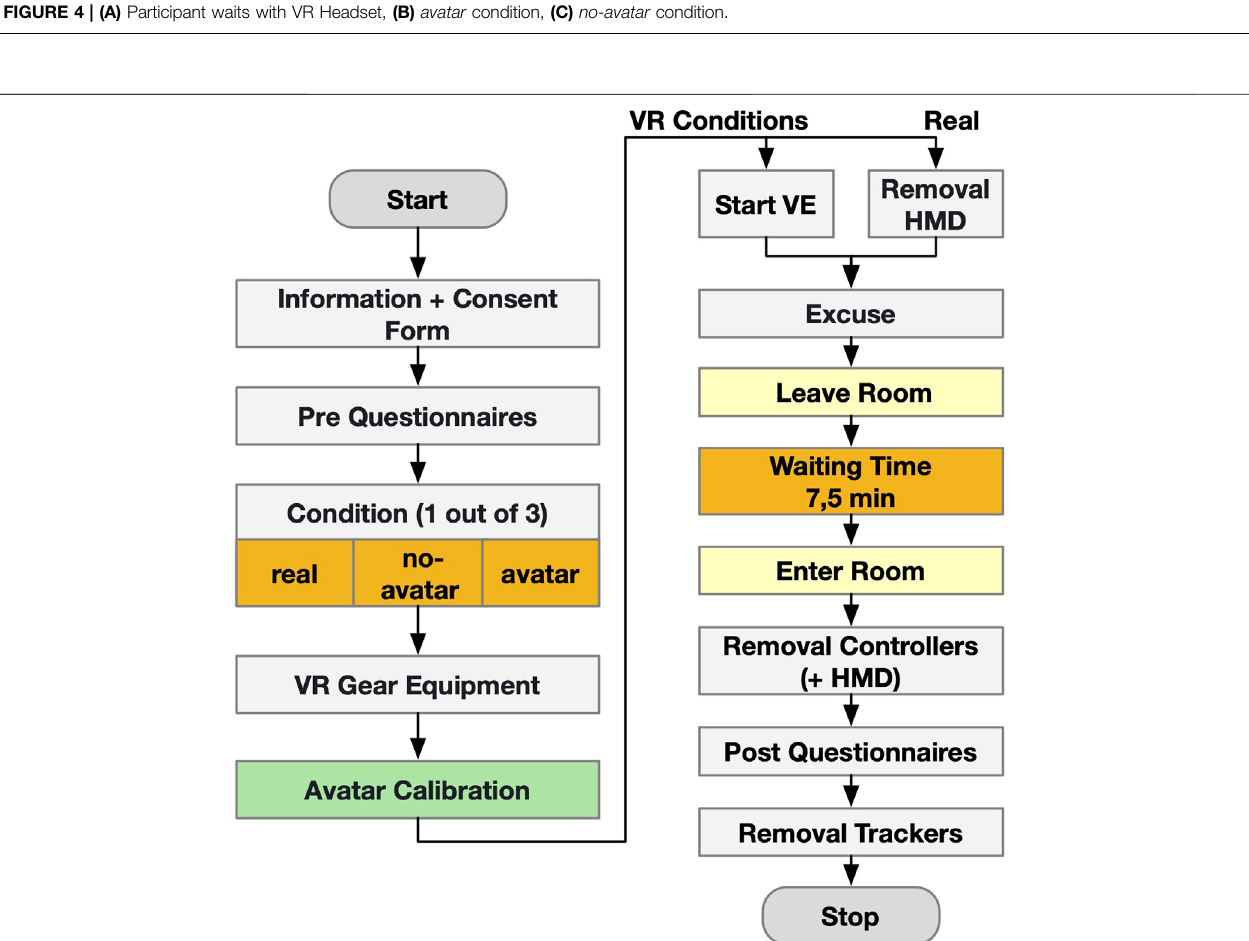
FIGURE 5 | Experimental conditions and procedure for each experimental